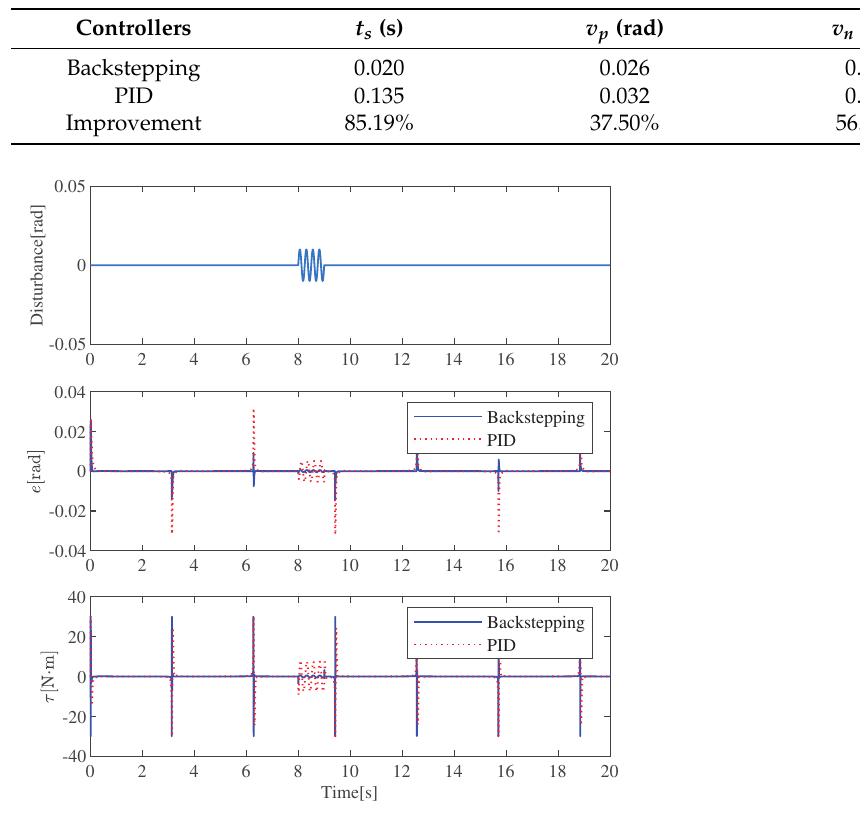
Figure 8. Comparative results with m c = 10 kg and